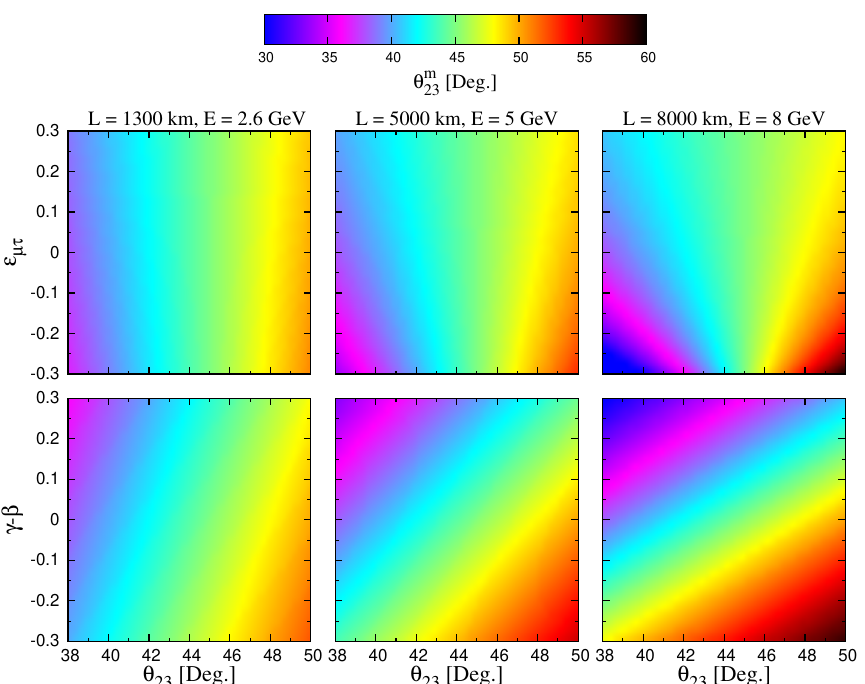
are shown in the plane of [ θ ] (top row) and [ θ ( γ − β ) ] Figure 3 . The evolution of θ m 23 − ε µτ 23 − 23 (bottom row). The left, middle, and right columns correspond to three sets of baseline and neutrino energy, namely (1300 km, 2.6 GeV), (5000 km, 5 GeV), and (8000 km, 8 GeV), respectively. Values